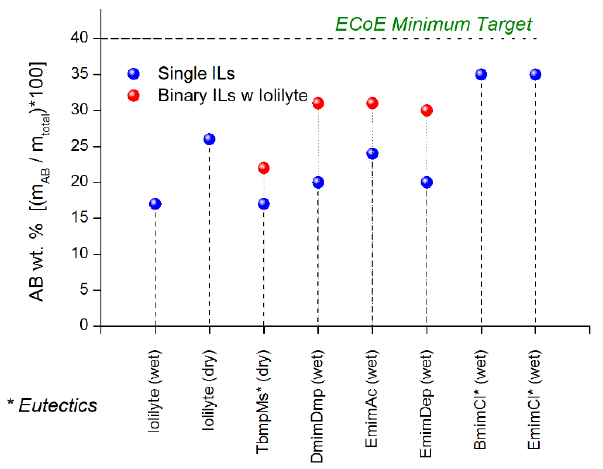
Figure 24. Maximum ammonia borane loadings for various ionic liquids and binary ionic liquids. Reproduced from [28].